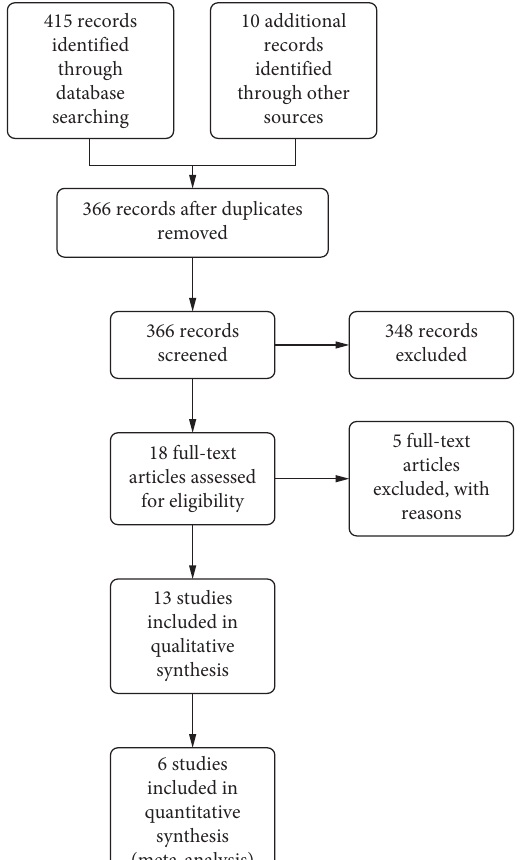
Figure 1: Prisma flowchart, preferred reporting items for sys- tematic reviews and meta-analyses. This depicts the selection of studies for